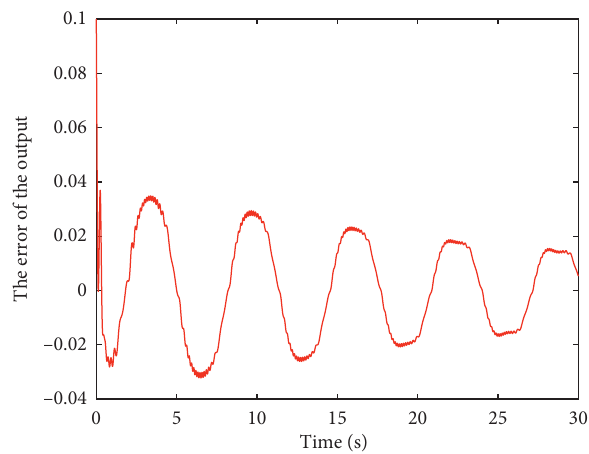
Figure 9: The errors of output with large input signal